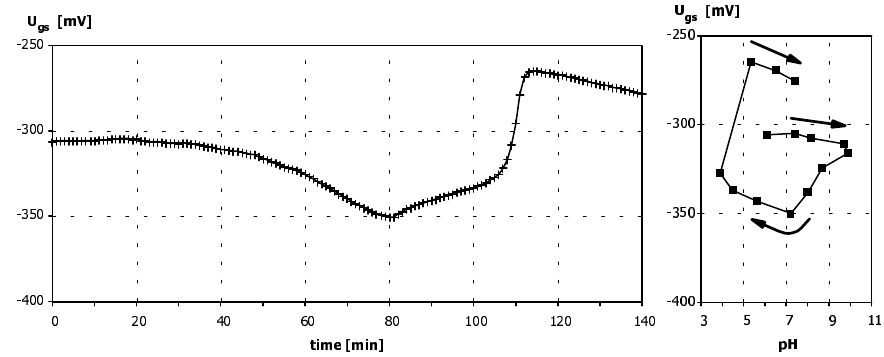
Figure 5. Dynamic response and calibration curve to pH of an ISFET with polyHEMA coating ca. 60 µm thick, deposited according to the Method 3. Cycle of pH changes: